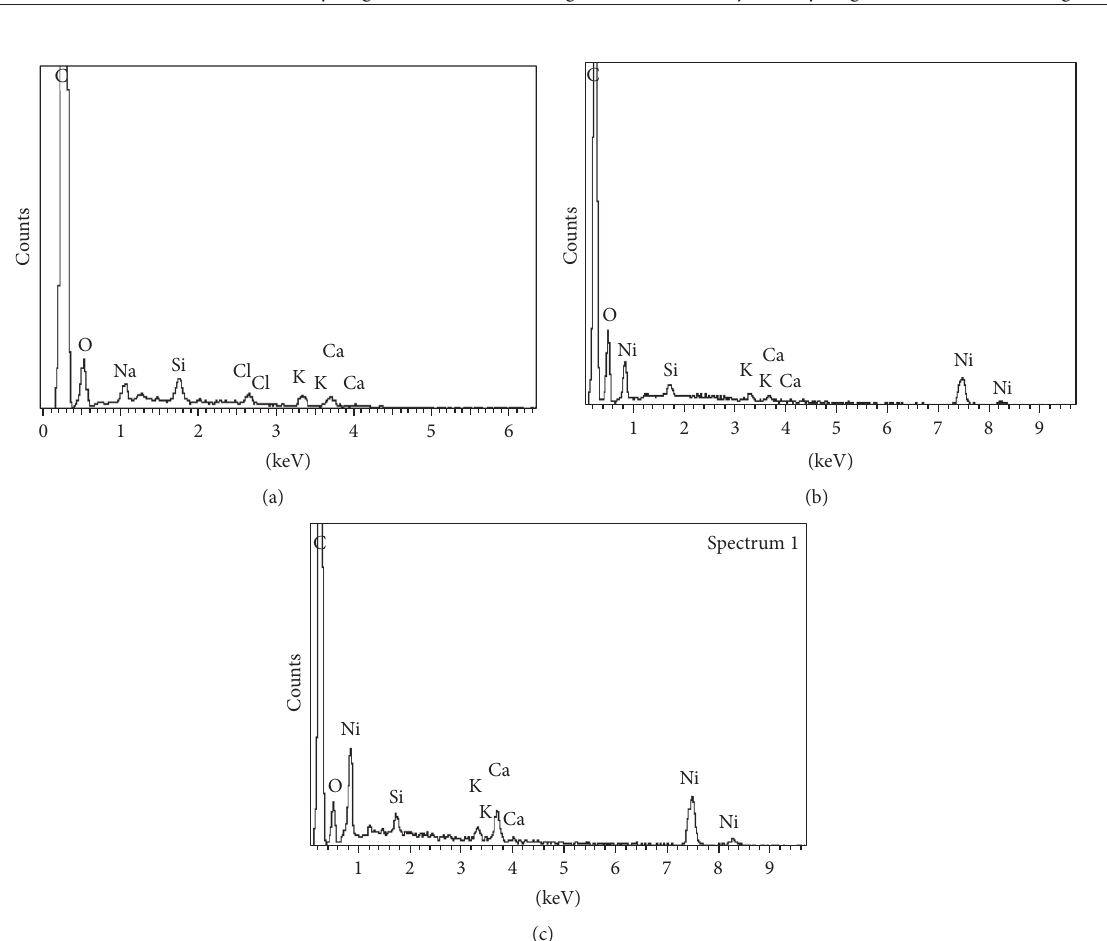
Figure 9: EDX spectrums for (a) PAC, (b) Ni impregnated PAC, and (c)